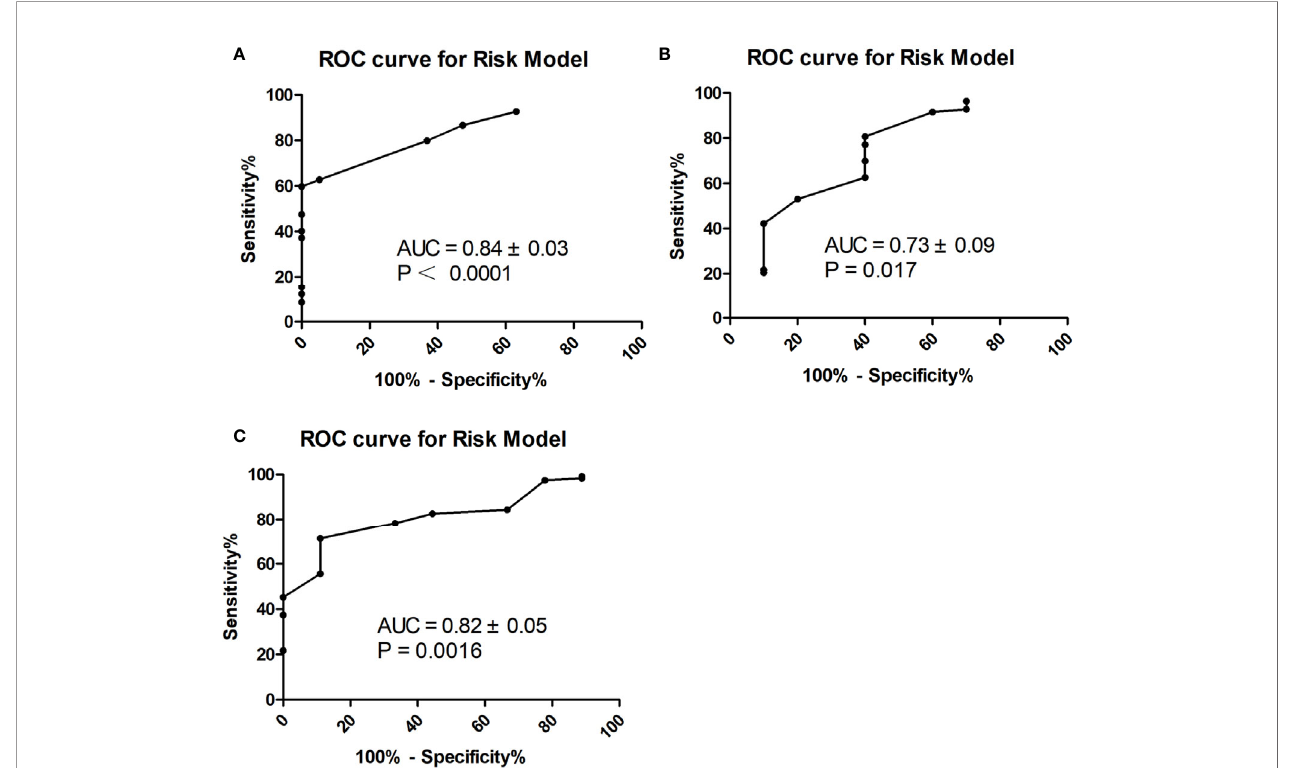
(P<0.05, Figure 1C ). The estimated median survival times of patients in the high- and low-risk TRG groups were unde fi ned and 37.50 months; the estimated 3-year survival rates were 76.75% and 53.45%, respectively. Therefore, this prediction model was also effective for prognosis.